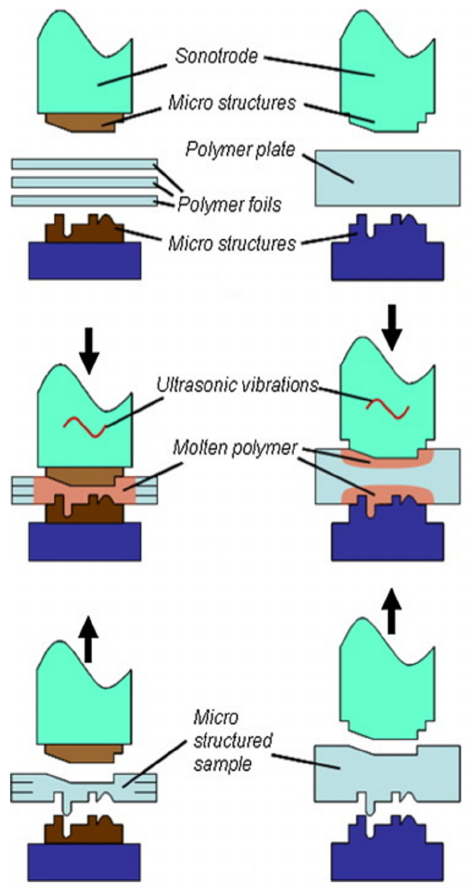
Figure 2 Figure 2. Ultrasonic hot embossing of a stack of foils (left) and a plate (right). Adapted, with permission, from [51] 2015,